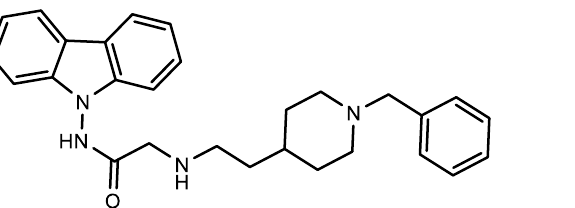
Figure 8. Structure of 2-((2-(1-benzylpiperidin-4-yl)ethyl)amino)- N -(9 H- carbazol-9-yl)acetamide ( 12 ).